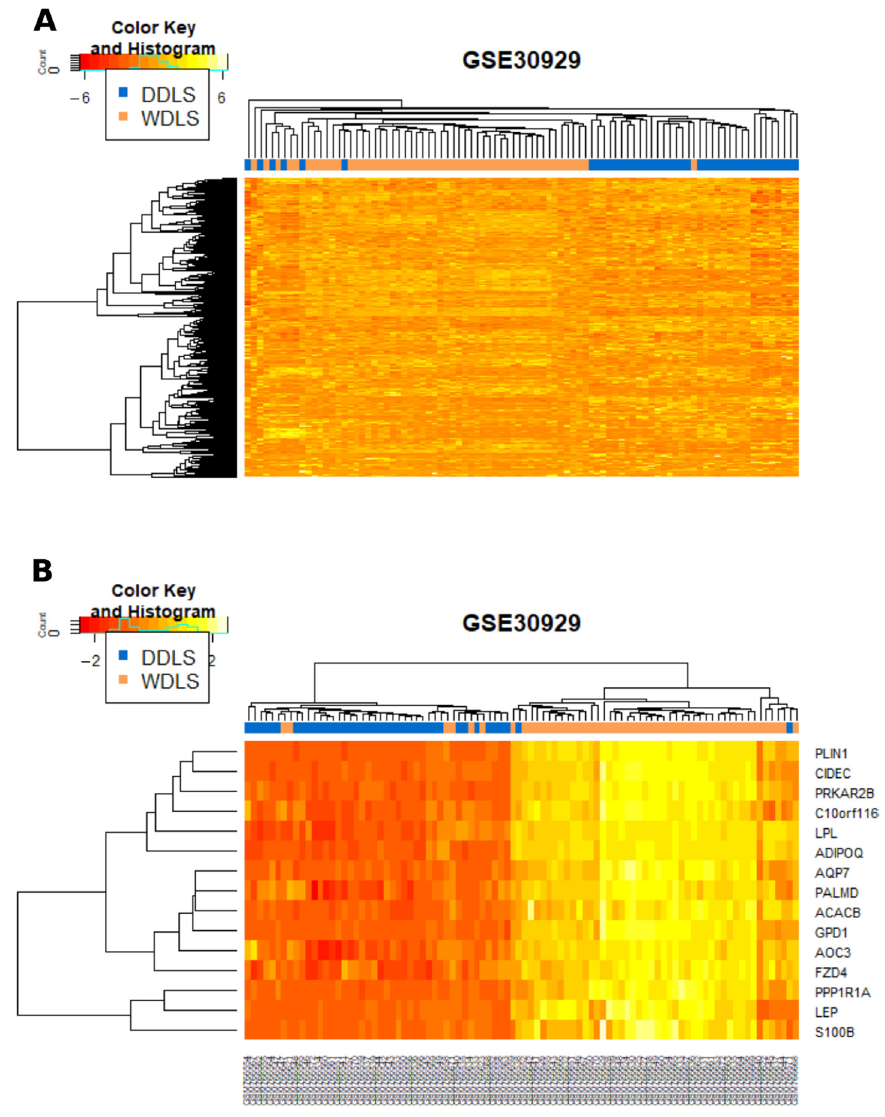
Figure 2. ( A ) Unsupervised clustering of dedifferentiated liposarcoma (DDLS) and well-differentiated liposarcoma (WDLS) from the GSE30929 dataset demonstrating segregation of the two subtypes. ( B ) Clustering of the GSE30929 dataset utilising the top 15 dysregulated genes between WDLS and DDLS. WDLS, well-differentiated liposarcoma; DDLS, dedifferentiated liposarcoma.